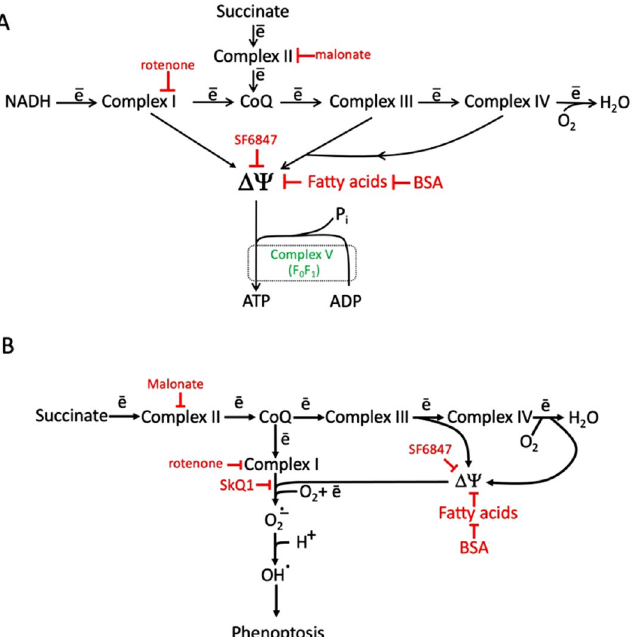
Figure 11. ( A ) Respiratory chains in mitochondria, reducing O 2 to H 2 O. ( B ) Respiratory chain in mitochondria, reducing O 2 to H 2 O and superoxide. The specific inhibitors of complexes I and II as are shown in red. Uncoupler SF6847 and fatty acids dissipated membrane potential (ΔΨ). BSA, bovine serum albumin removing fatty